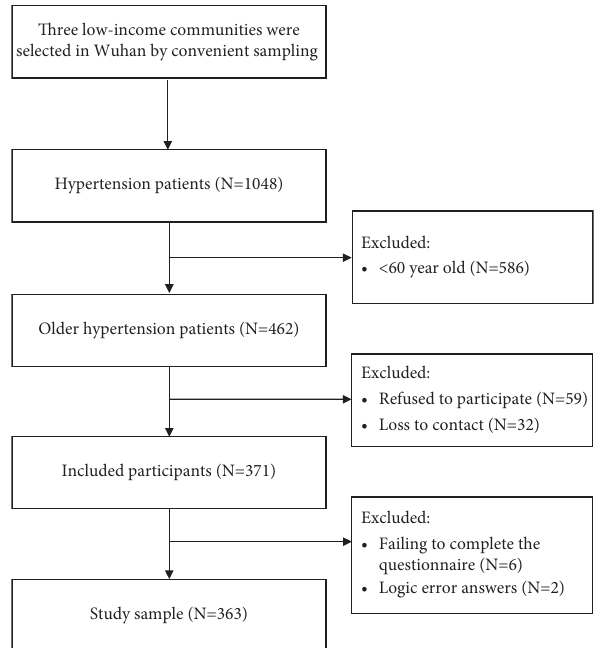
Figure 1: Sample selection flow